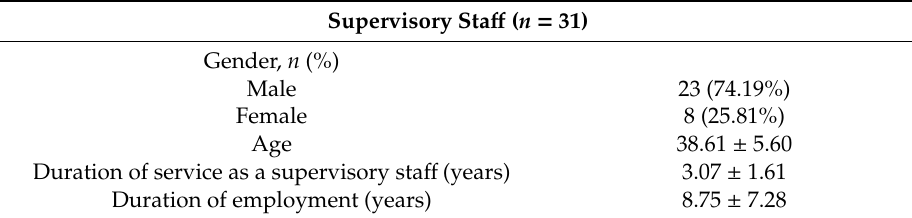
Table 2. Background information of the supervisory sta ff and